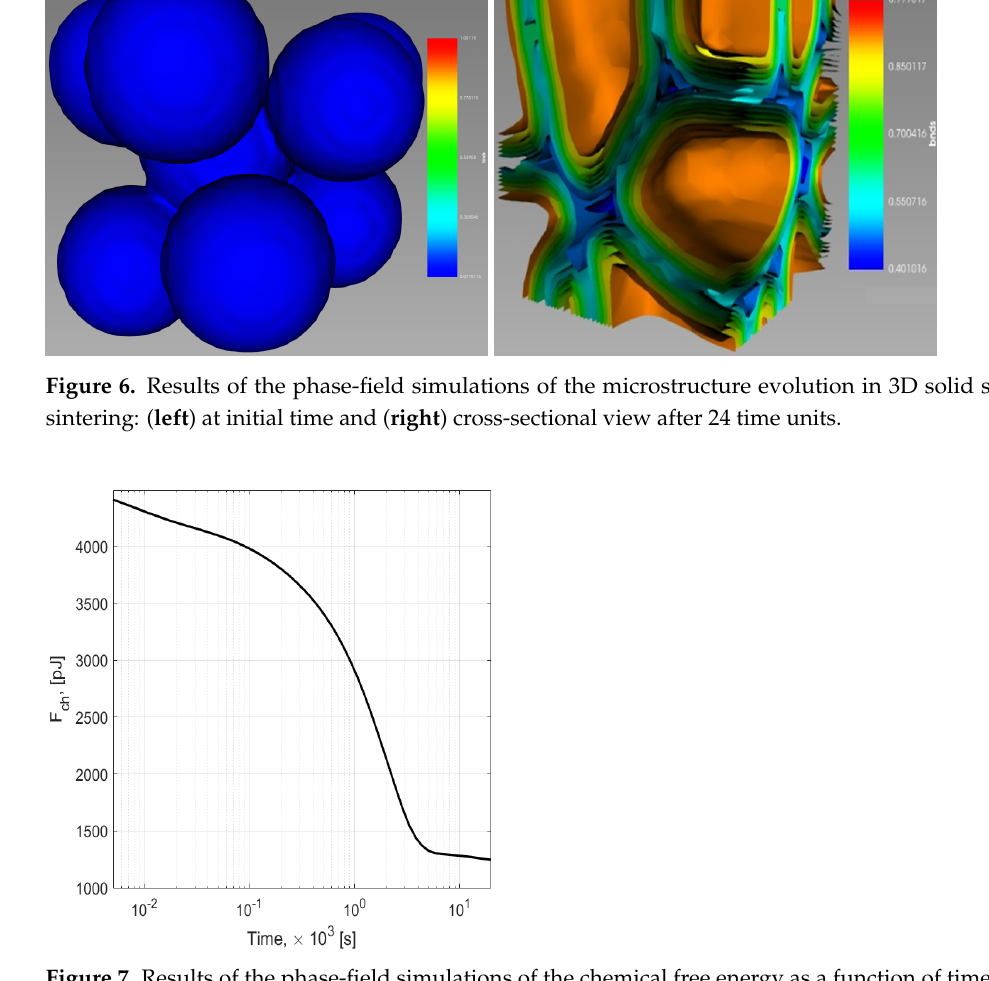
Figure 7. Results of the phase-field simulations of the chemical free energy as a function of time. Sintering